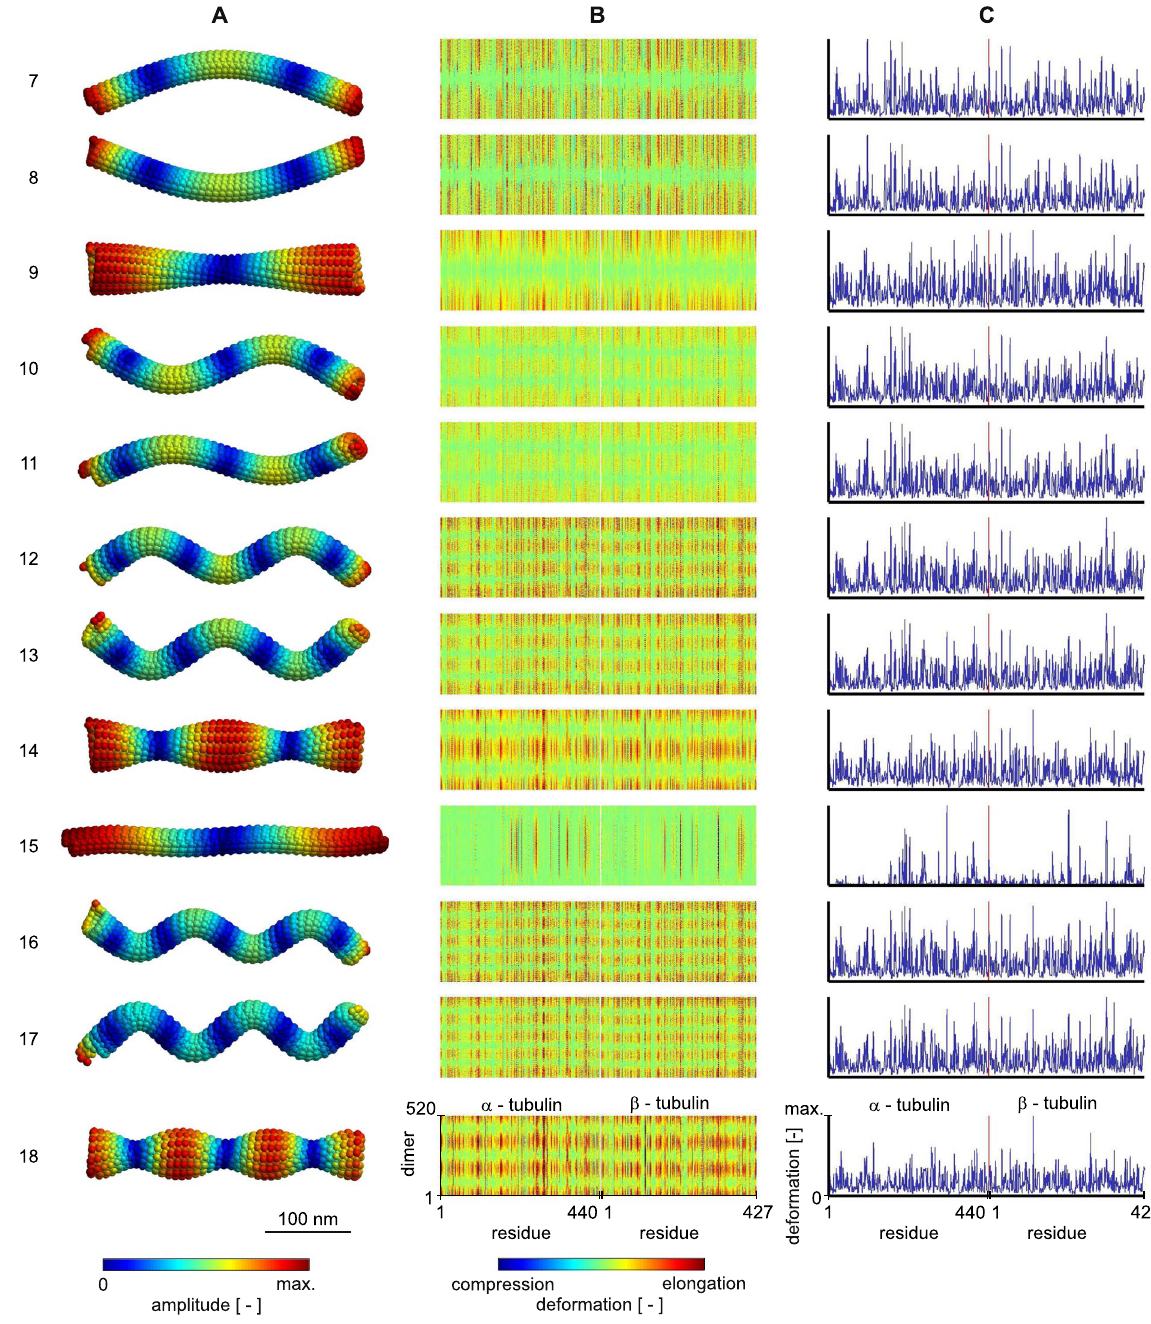
Figure 3. First twelve non-rigid normal modes of a microtubule. ( A ) the shapes of the modes with fluctuations mapped on the surface of the microtubule. ( B ) the deformation pattern in individual residues of αβ -tubulin dimers in the pseudo-helical lattice of a microtubule. Columns of the maps show residues within the sequence of tubulin and rows show individual dimers. ( C ) average absolute deformation in dimer. Red vertical line represents the boundary between tubulin monomers. Note that all deformation data are normalized to the maximum within respective